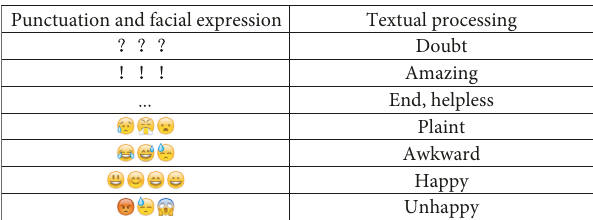
Table 1: Comparison table of punctuation and facial expressions in textual processing.